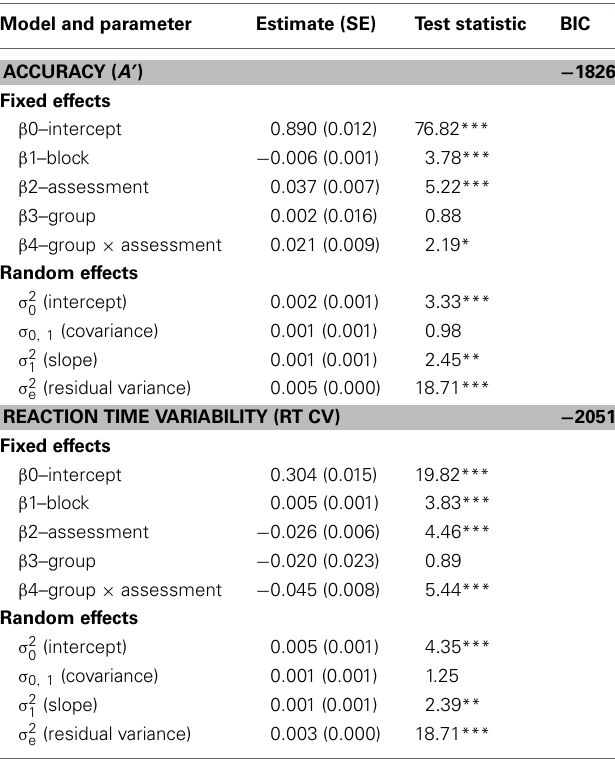
Table 2 | Parameter estimates from models of RIT